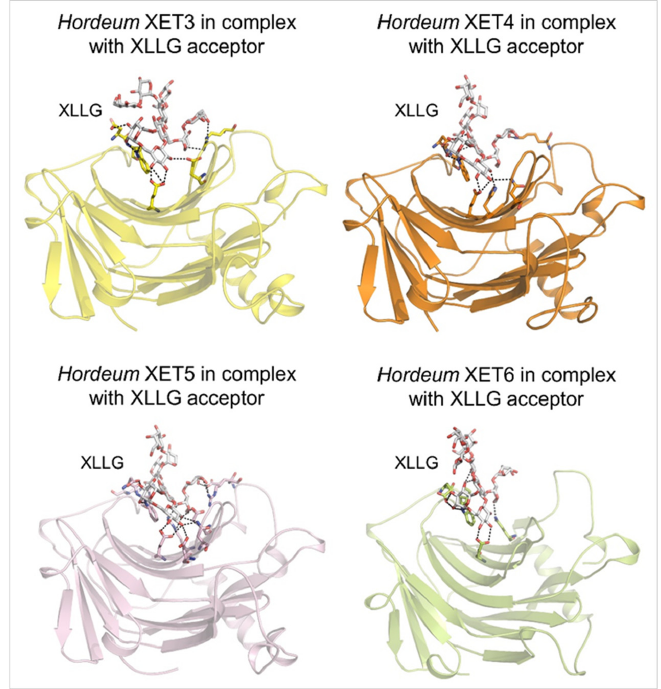
Figure 3. Molecular models of the β -sandwich architecture with the β -jelly-roll topology of Hordeum XET3 (top left; yellow), Hordeum XET4 (top right; orange), Hordeum XET5 (bottom left; pink), and Hordeum XET6 (bottom right; lemon) in complex with the XLLG acceptors (cpk sticks). Coordinates of XET3, XET4 and XET6 with XLLG were taken from [81] and those of XET5 from [64]. XLLG was docked in XET5 by HDOCK that performs docking based on a hybrid algorithm of template-based modelling and ab initio free docking [98]; the top docking pose is shown for XET5 from 100 poses ranked by energy docking scores. Details of binding of XLLG by Hordeum XETs are shown in dashed lines. Separations are for XET3: 2.7 Å to 3.6 Å; XET4: 2.6 Å to 3.5 Å; XET5: 2.5 Å to 3.6 Å; XET6: 2.5 Å to 3.2 Å. Images were generated in PyMOL as referenced in Figure